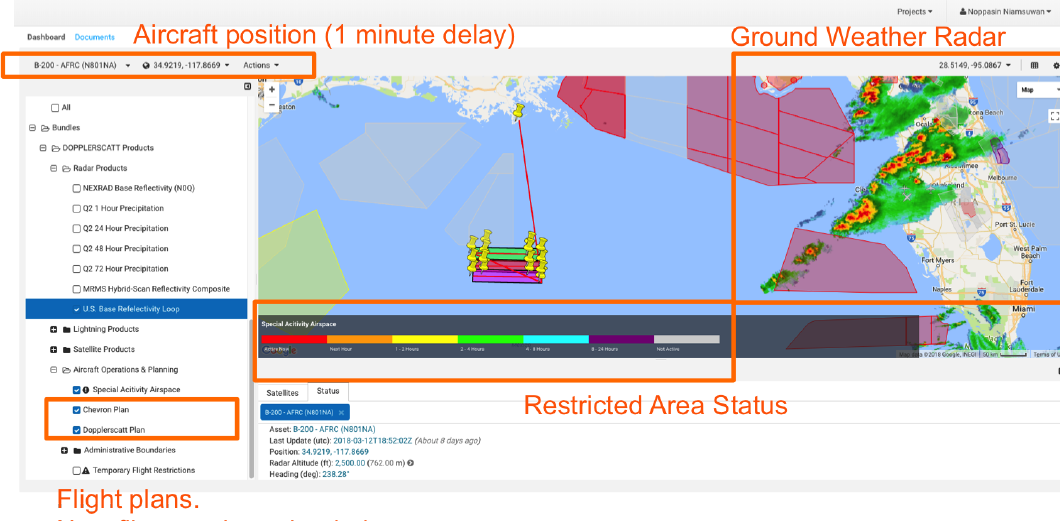
Figure 10. The NASA Mission Tools Suite allows for all relevant operational information to be displayed on a single map. This screenshot shows the waypoints from a deployment in the Gulf of Mexico, along with the DopplerScatt swath, no-fly zones, and NEXRAD weather radar data. During flight, MTS can track the aircraft in real